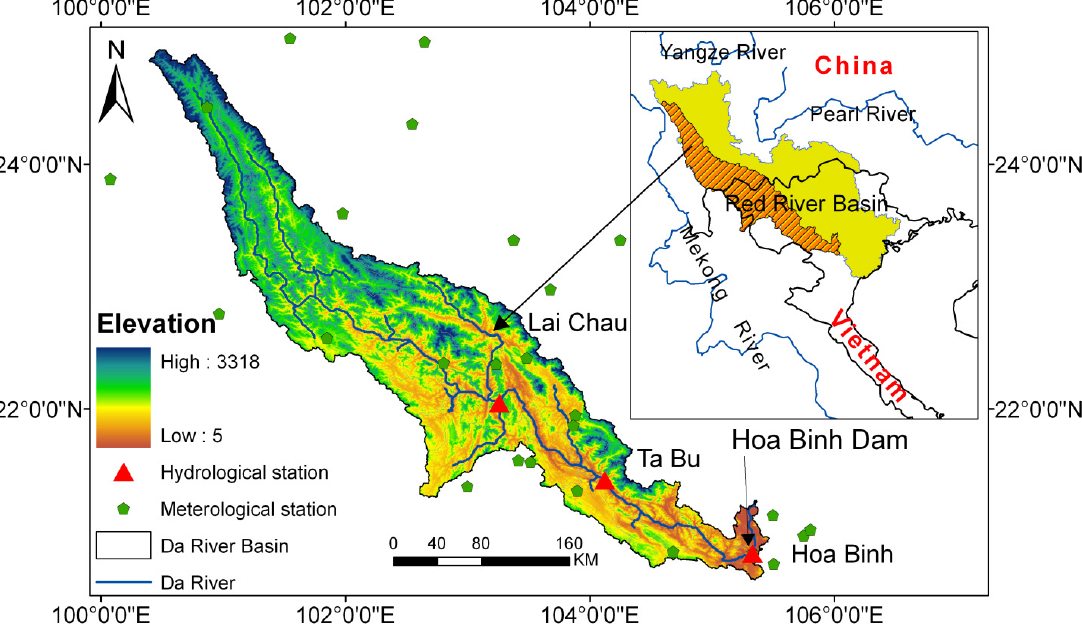
Figure 1. Location of the DRB and the meteorological stations.